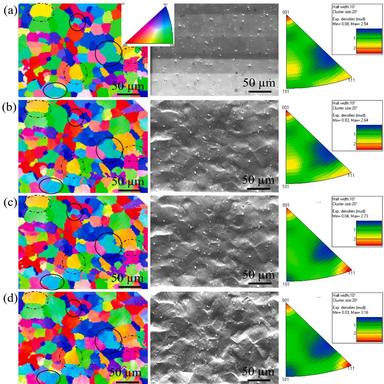
On the left: EBSD mappings, in the middle: SEM images and on the right: inverse pole figure (IPF) X mapping of the centre of the AA5182-O specimen at (a) uniaxial start, (b) uniaxial end, (c) biaxial start and (d) biaxial end during continuous strain path change.